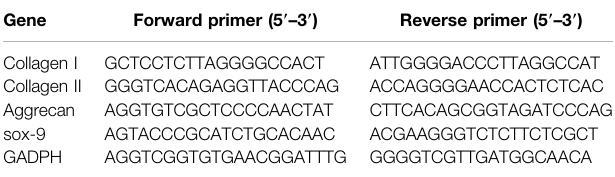
TABLE 1 | Primers used for RT-PCR analysis.